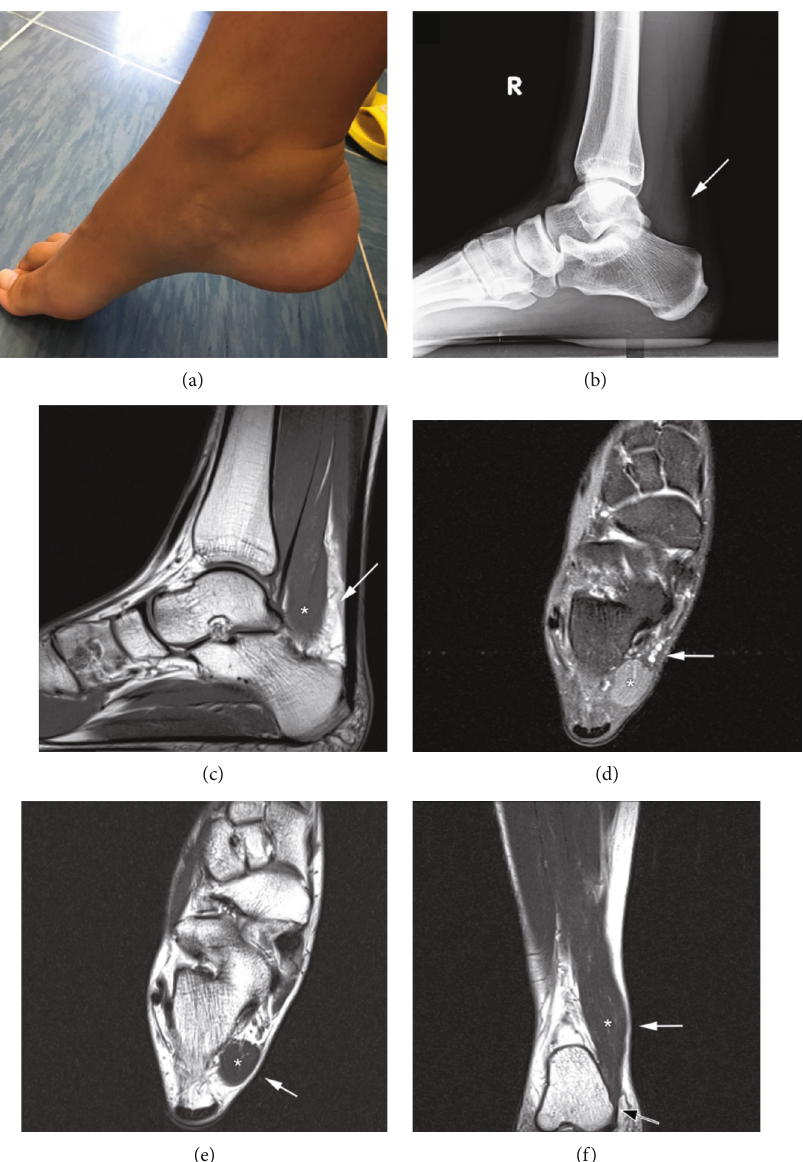
Figure 1: Preoperative images of the patient ’ s right ankle presented in the fi rst case. (a) A swelling is visible in the posteromedial part of the right ankle, which is more prominent in plantar fl exion. (b) Obliteration of Kager ’ s fat pad visible on the plain lateral radiograph of the right ankle is pointed by a white arrow. (c) T1-weighted sagittal MR image of the right ankle. Accessory soleus muscle (ASM) is marked with an asterisk ( ∗ ), and obliteration of the Kager ’ s fat pad is pointed by a white arrow. (d) T2-weighted axial MR image of the right ankle. ASM is marked with an asterisk ( ∗ ), and neurovascular bundle in the posteromedial part of the ankle is pointed by a white arrow. (e) T1-weighted axial MR image of the right ankle. ASM is marked with an asterisk ( ∗ ), and elevation of the skin and subcutaneous tissue is pointed by a white arrow. (f) T1-weighted coronal MR image of the right ankle. ASM is marked with an asterisk ( ∗ ), the elevation of the skin and subcutaneous tissue is pointed by a white arrow, and muscular insertion of the ASM on the medial side of the calcaneus is pointed by a black